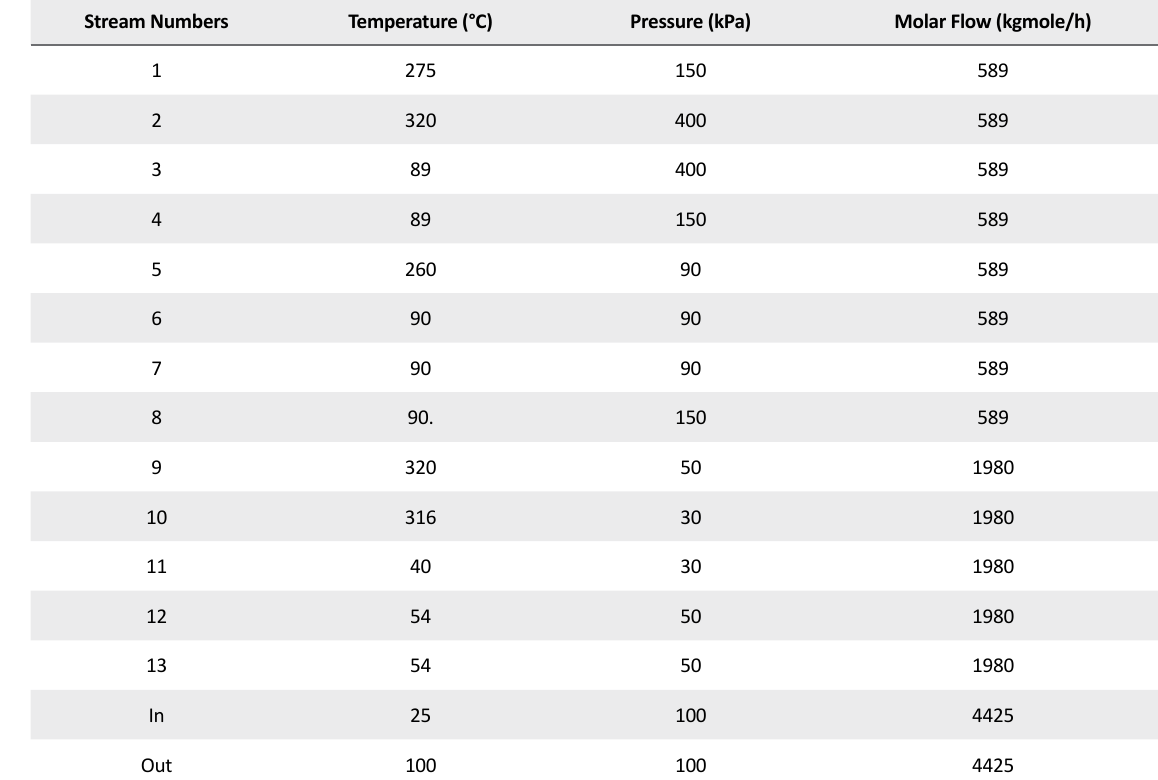
Table 1. Data of solar hot water production system of hot water production system with weather conditions of